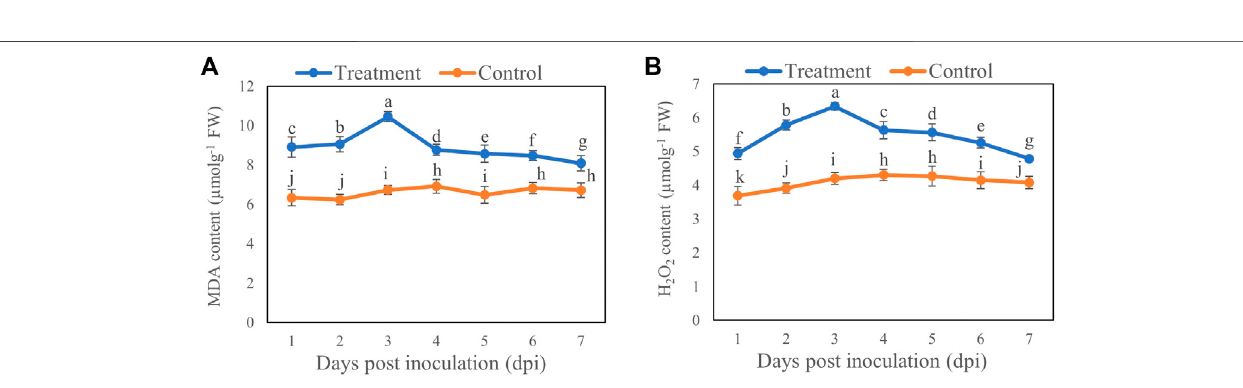
FIGURE4| The (A) MDAand (B) H 2 O 2 contentsof B.brassicae atdifferenttimepointsafterinoculationwith T.longibrachiatum T6.Differentsmalllettersrepresent the signi fi cant difference at the p < 0.05 level by Duncan ’ s new multiple range test. The line bars represent means ± standard error.